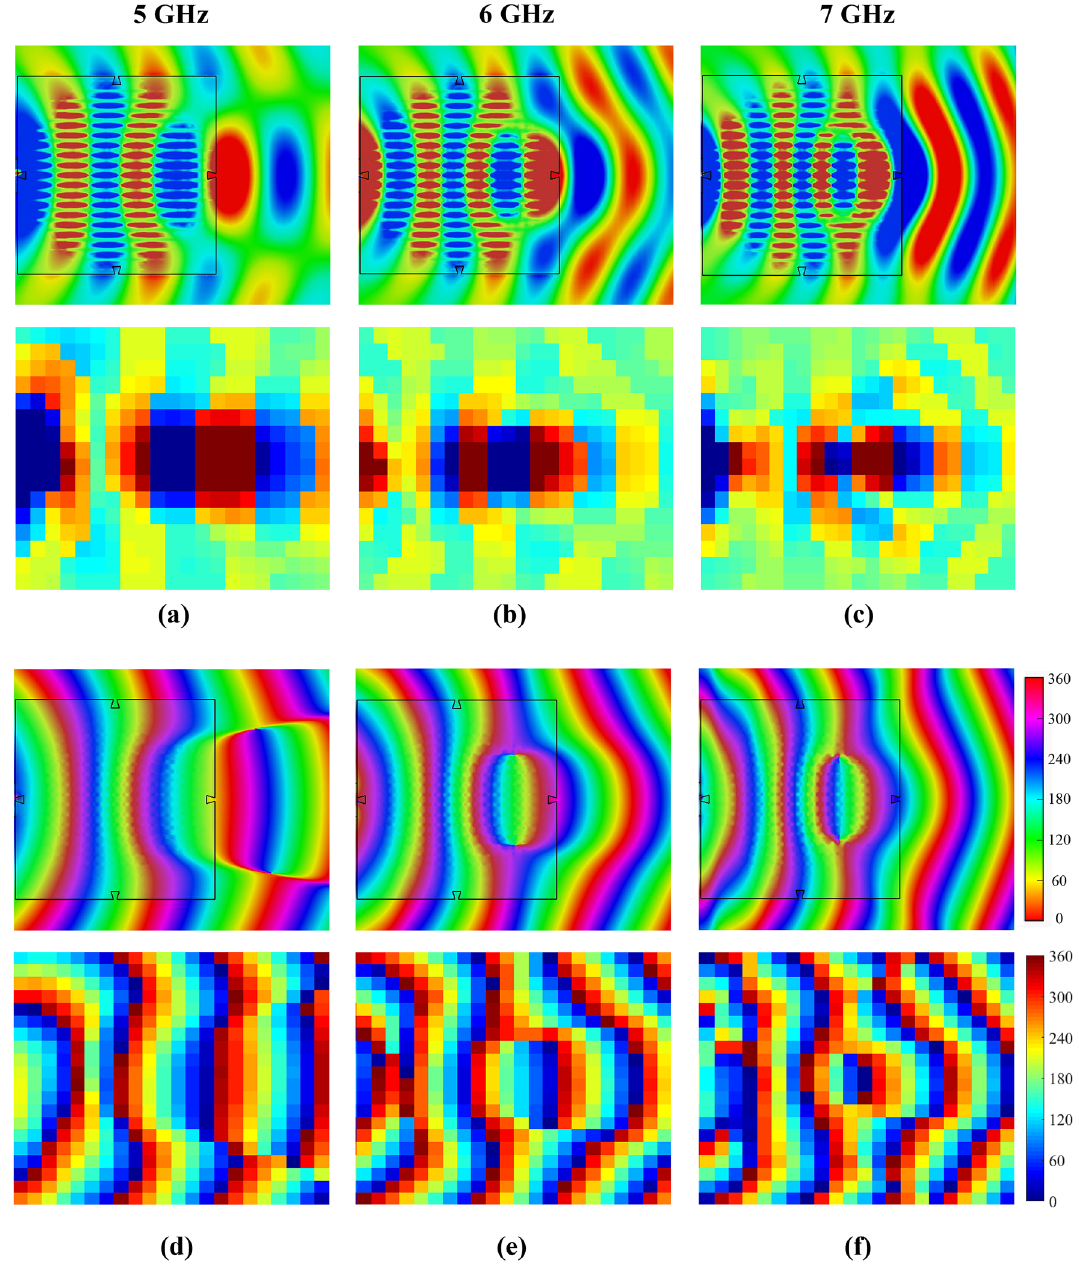
Figure 14. Comparisons of near electric-field distributions ( E y ) on xoy -plane between the simulated results (upper part of each subgraph) and measured results (bottom part of each subgraph) at 5, 6, and 7 GHz when the proposed bifunctional metalens serves as a fisheye lens. ( a,b,c ) Amplitude distributions of simulated and measured electric field at 5, 6, and 7 GHz, respectively. ( d,e,f ) Phase distributions of simulated and measured electric field at 5, 6, and 7 GHz,